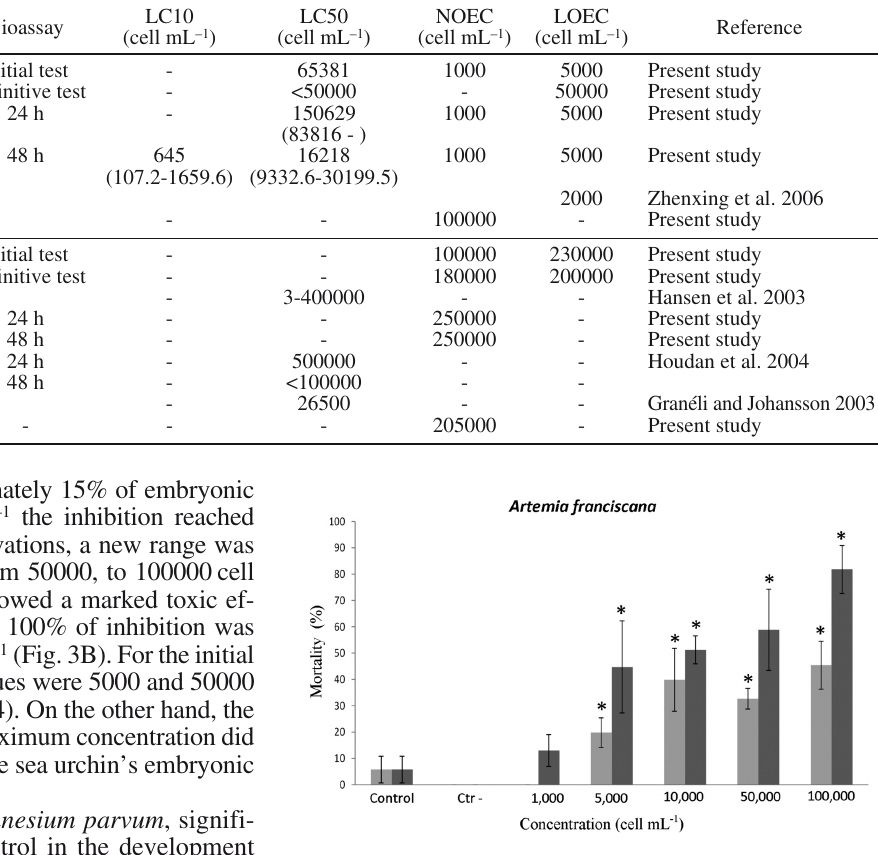
and LC ) and their respective confidence 10 50